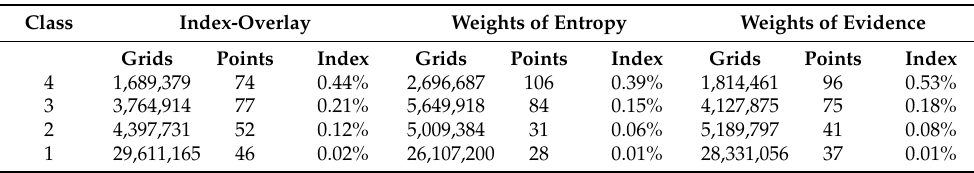
Table 7. Success indices from the classification maps of prediction.